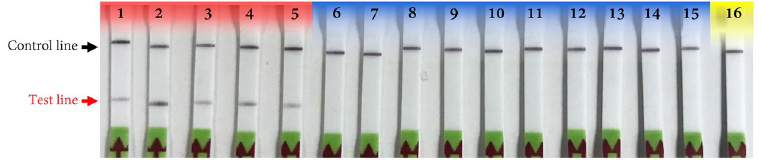
Figure 5. The analytical specificity of recombinase polymerase amplification (RPA) assay for target pathogen, Pectobacterium sp. Lane 1 - P . carotovorum subsp. carotovorum (A5280); lane 2 - P . carotovorum subsp. odoriferum (A1089); lane 3 - P . carotovorum subsp. brasiliensis (A2688); lane 4 - P . atrosepticum (A1850); lane 5 - P . parmentieri (A1852); lane 6 - Dickeya zeae (A6056); lane 7 – D . zeae (A5422); lane 8 - D . dadantii (A5642); lane 9 - D . chrysanthemi (A5641); lane 10 - D . solani (A5581); lane 11 - D . solani (A5582); lane 12 - Clavibacter michiganensis subsp. michiganensis (A2058); lane 13 - C . michiganensis subsp. nebraskensis (A6095); lane 14 - Xanthomonas vesicatoria (A3617); lane 15 - Ralstonia solanacearum (A5491); and lane 16 – non-template control (water).